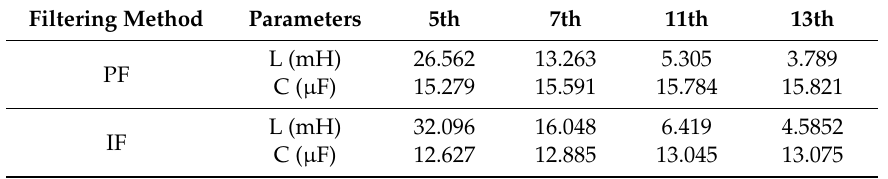
Table 2. Parameters of filters. PF: passive filtering; IF: inductive filtering; L: inductance; C: capacitance.